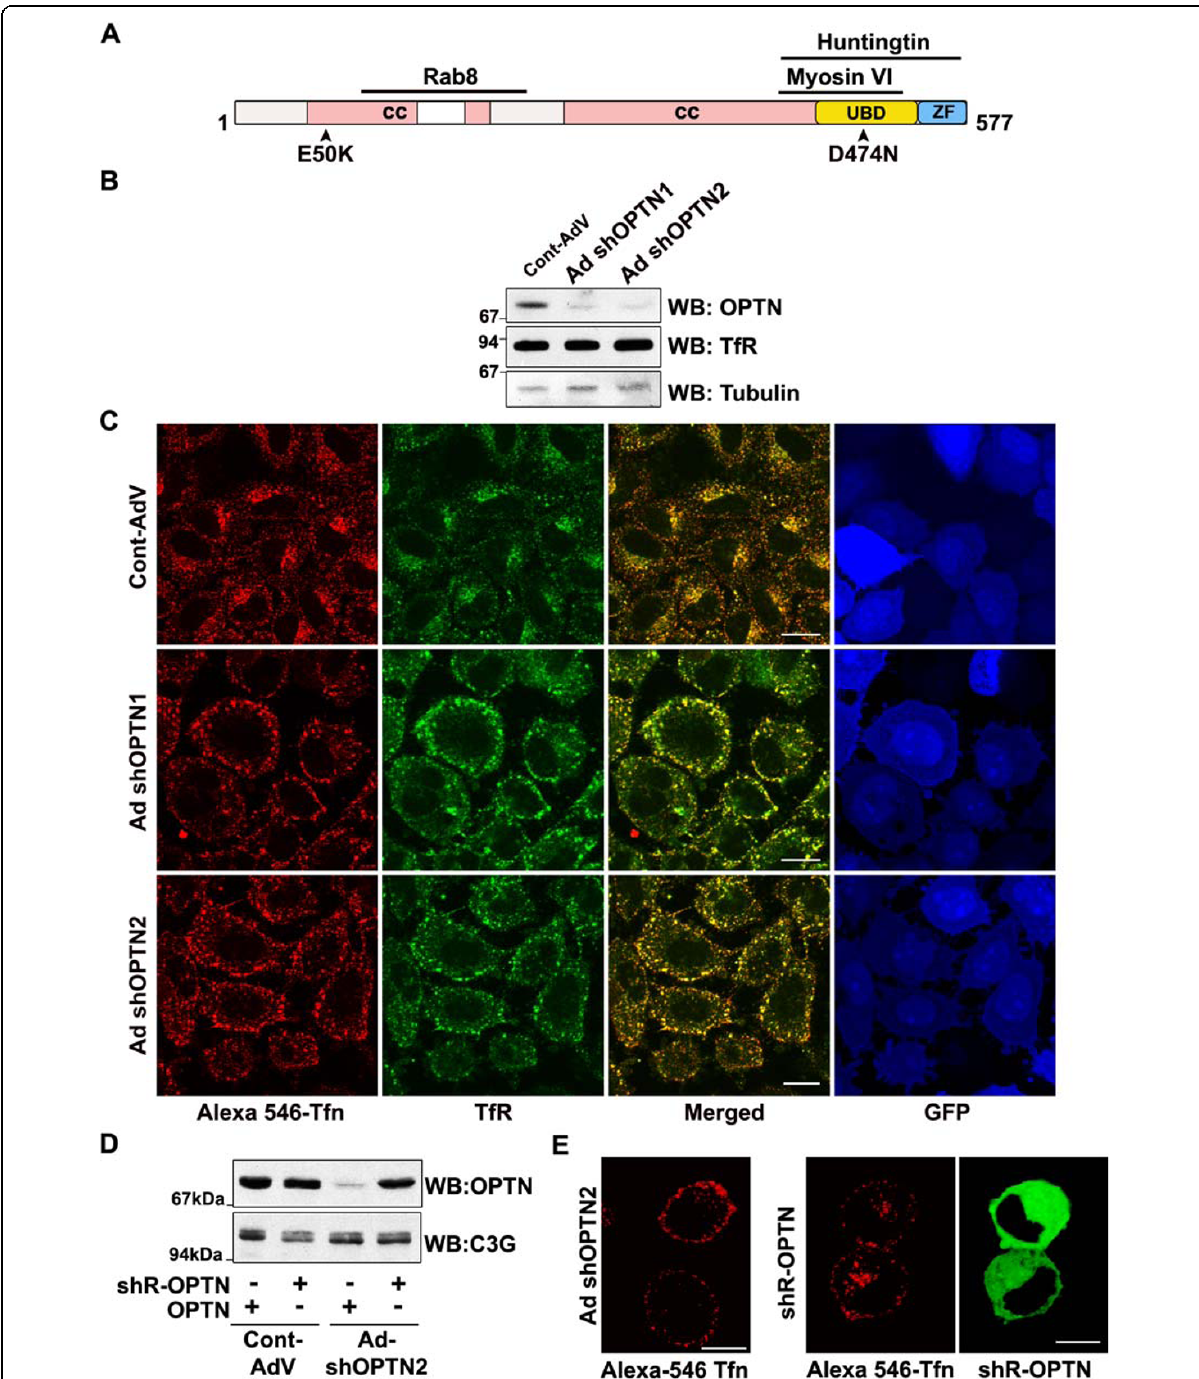
Figure 1 Optineurin is required for the trafficking of TfR . (A) Schematic representation of optineurin showing domain organisation, key mutations and binding sites of interacting proteins. UBD- Ubiquitin Binding Domain (424-511aa), CC-coiled coil domain, ZF- zinc finger domain. (B) HeLa cells were infected with adenoviruses expressing shRNAs (Ad shOPTN1 and Ad shOPTN2) against optineurin for 72 hrs. Western blots show levels of endogenous optineurin, TfR and tubulin. (C) HeLa cells were infected with adenoviruses expressing shRNAs for 72 hrs, serum starved for 2 hrs and then incubated with Alexa-546 conjugated transferrin for 15 min, stained for transferrin receptor and examined by confocal microscopy. (D) Expression of shRNA resistant mutant of optineurin in HeLa cells. (E) HeLa cells infected with adenoviruses expressing shRNA (Ad shOPTN2) were transfected with a shRNA resistant mutant of optineurin and were incubated with Alexa 546-Tfn for 15 min. Expression of shRNA resistant mutant (right panels, shown in green) rescues the effect of shRNA. Bar; 10 μ